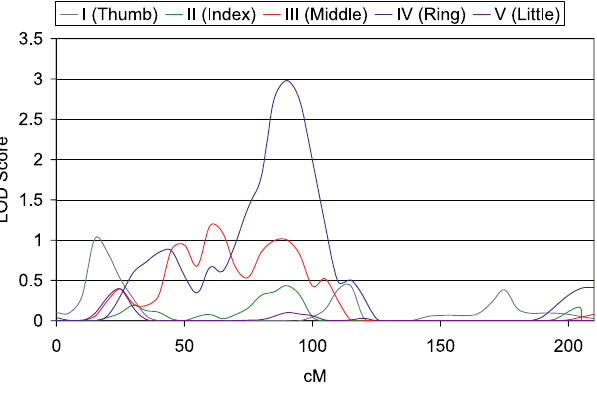
Figure 3. Univariate Variance Components Linkage Analyses for Individual Finger Ridge Count on Chromosome